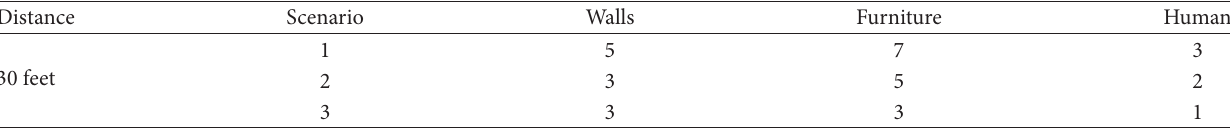
Table 5: Case 3 of experimental setup.